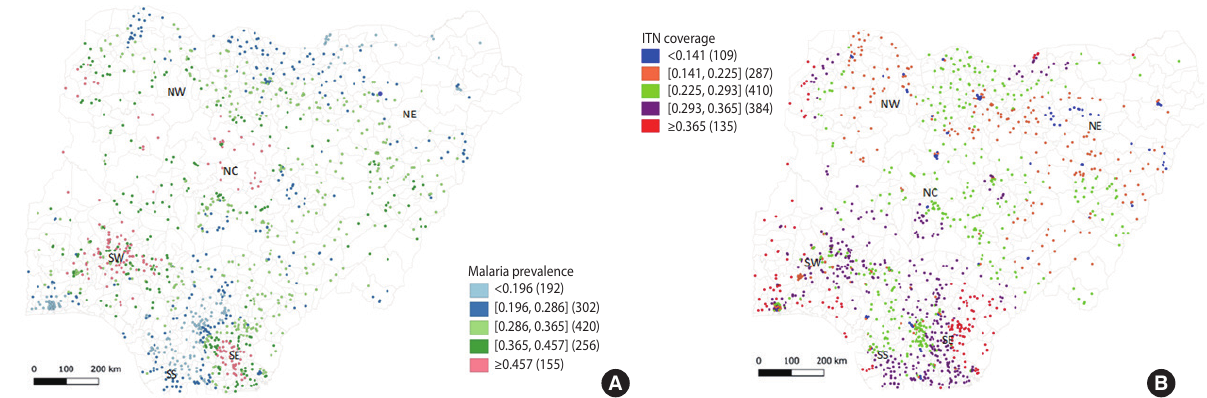
Figure 1. Malaria (A) and insecticide-treated net (ITN) distribution (B) across the geopolitical zones of Nigeria.